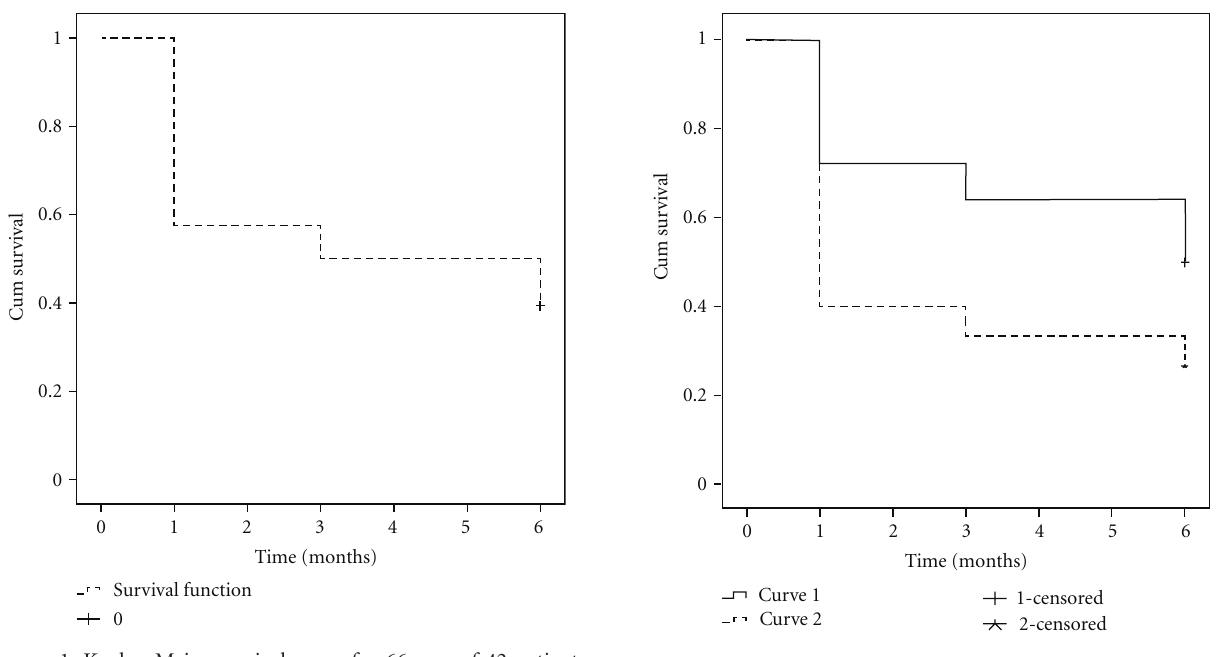
We did not find any intra- or postoperative SLT